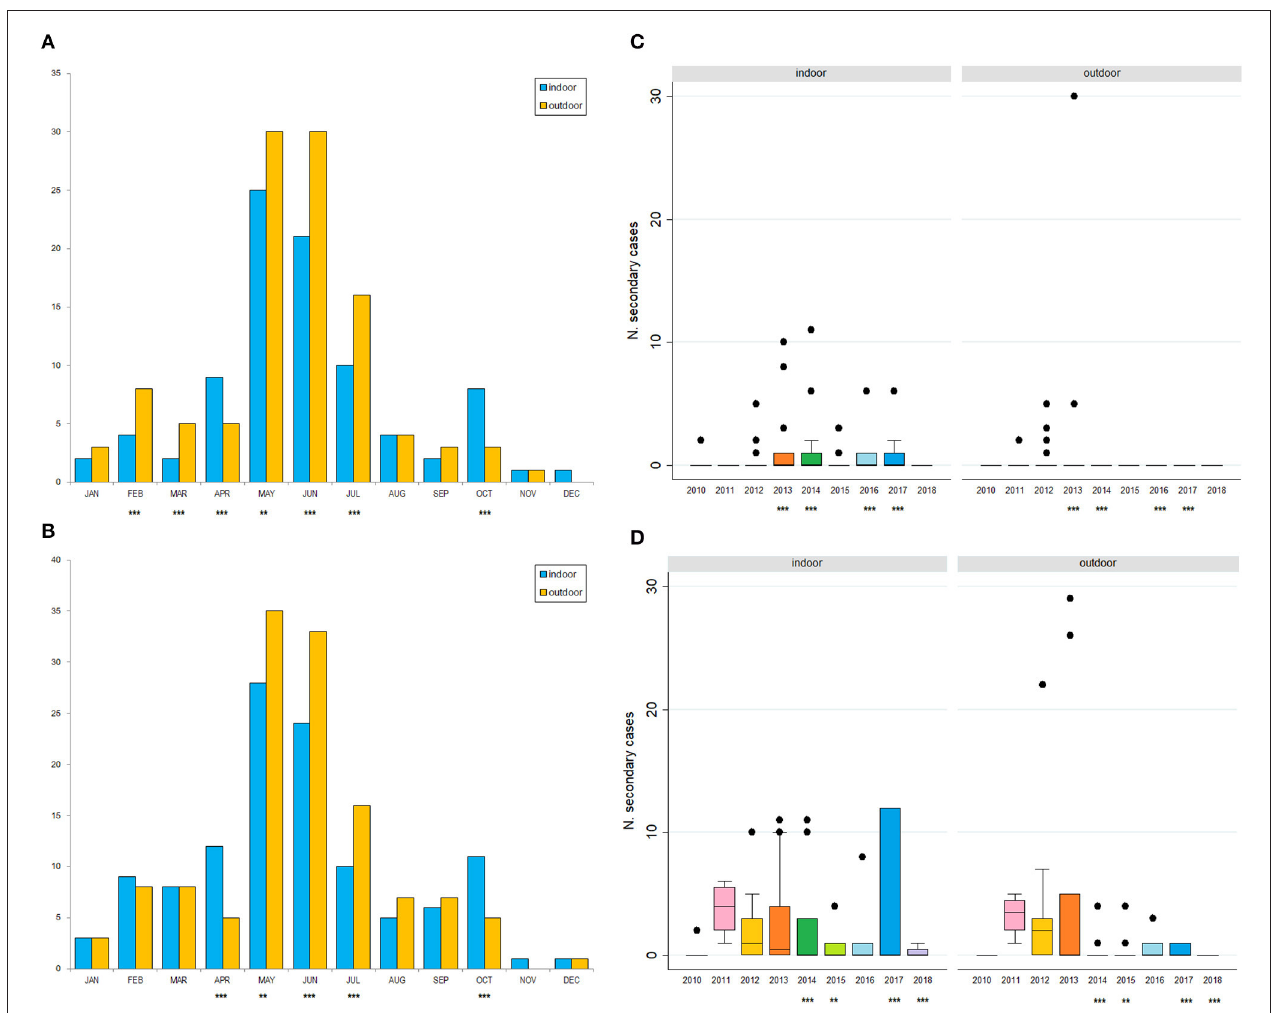
FIGURE 4 | Number of the secondary cases by year distribution (A–C) and overall month distribution (B–D) from 2010 to 2018. Data are represented by the number of secondary cases defined by nearest-neighbor (A,B) or uniform-smoothed kernel functions (C,D) . Statistically significant differences between indoor and outdoor farms are identified by a p -value < 0.0001 (***), or p -value between 0.05–0.0001